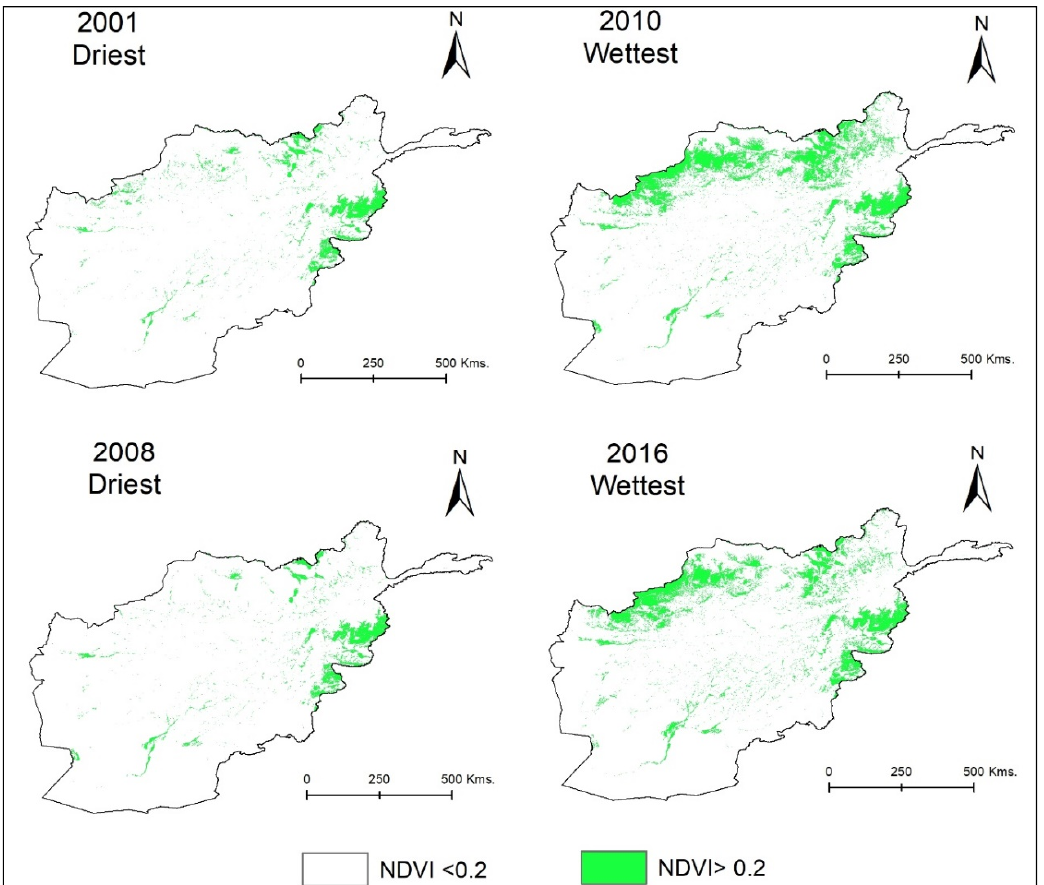
Figure 6. Annual mean NDVI for the driest and wettest years in Afghanistan between 2001 and 2018.